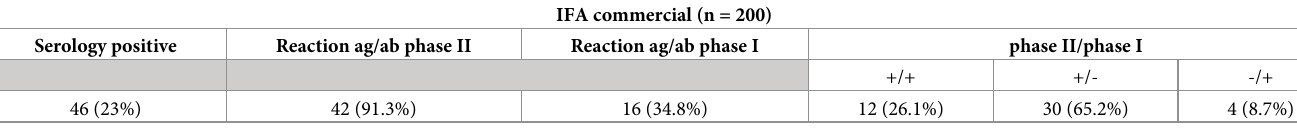
Table 2. Detection of anti- C . burnetii phase II and phase I antibodies.